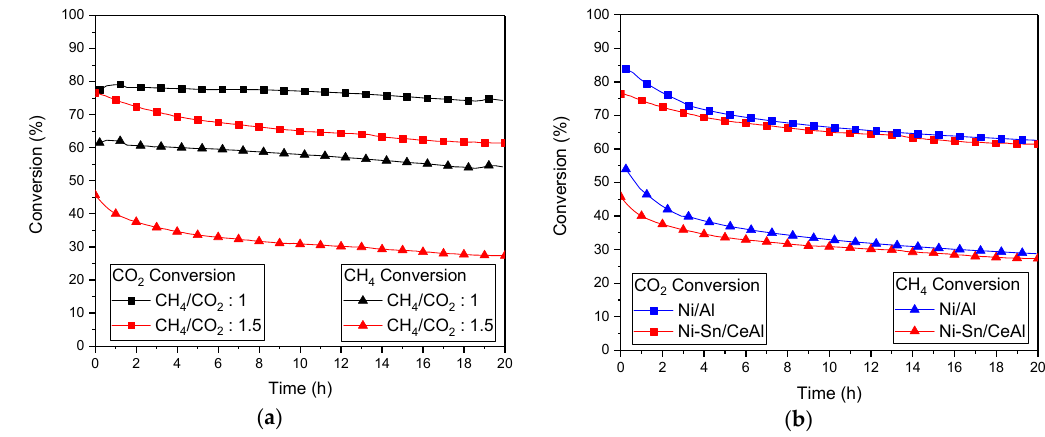
Figure 7. Dry reforming of methane (DRM) stability test at 650 ◦ C on ( a ) Ni-Sn/CeAl at CH 4 /CO 2 molar ratios of 1 (model biogas) and 1.5 (sewage waste) and ( b ) Ni-Sn/CeAl and Ni/Al catalyst using CH 4 /CO 2 molar ratios of 1.5: CO 2 and CH 4